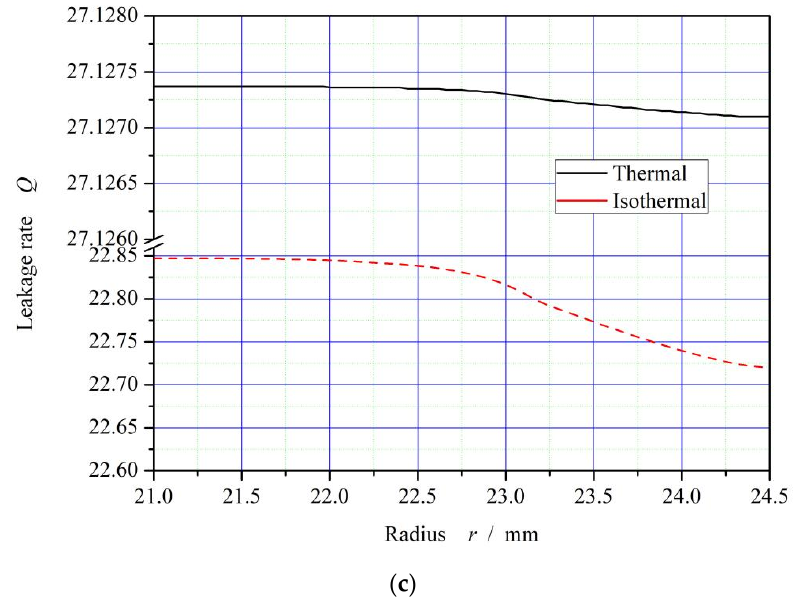
Figure 6. Schematic diagram of the pressure distributions and flow conservation ( ω = 20,000 rpm, P o = 4, h 0 = 2 μ m, h d = 5 μ m, b = 0.20 mm, γ = 3, α = 45°, N = 80). ( a ) Thermohydrodynamic pressure distribution; ( b ) Isothermal pressure distribution; ( c ) Curves of fl ow conservation.